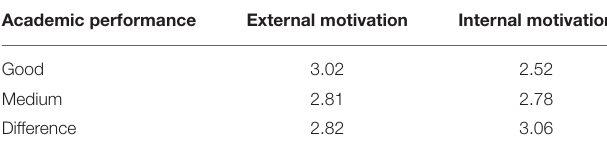
TABLE 2 | The types of learning motivation and academic